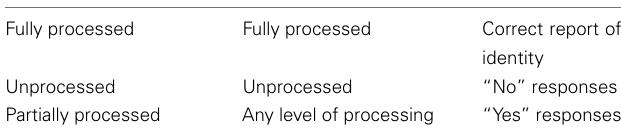
Table 1 | Different degrees of processing and their corresponding responses from the